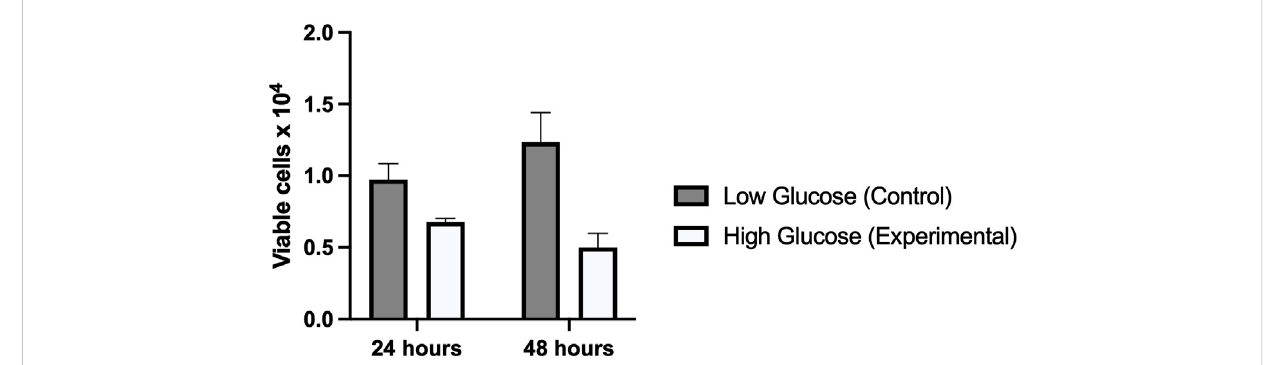
FIGURE 3 GraphicalrepresentationofMTTassaywhichshowsasigni fi cantlyreducedviabilityofcellstreatedwithhighglucoseascomparedtolowglucosefor 24 and 48 h. The viability further reduced in high glucose treated for 48 h.